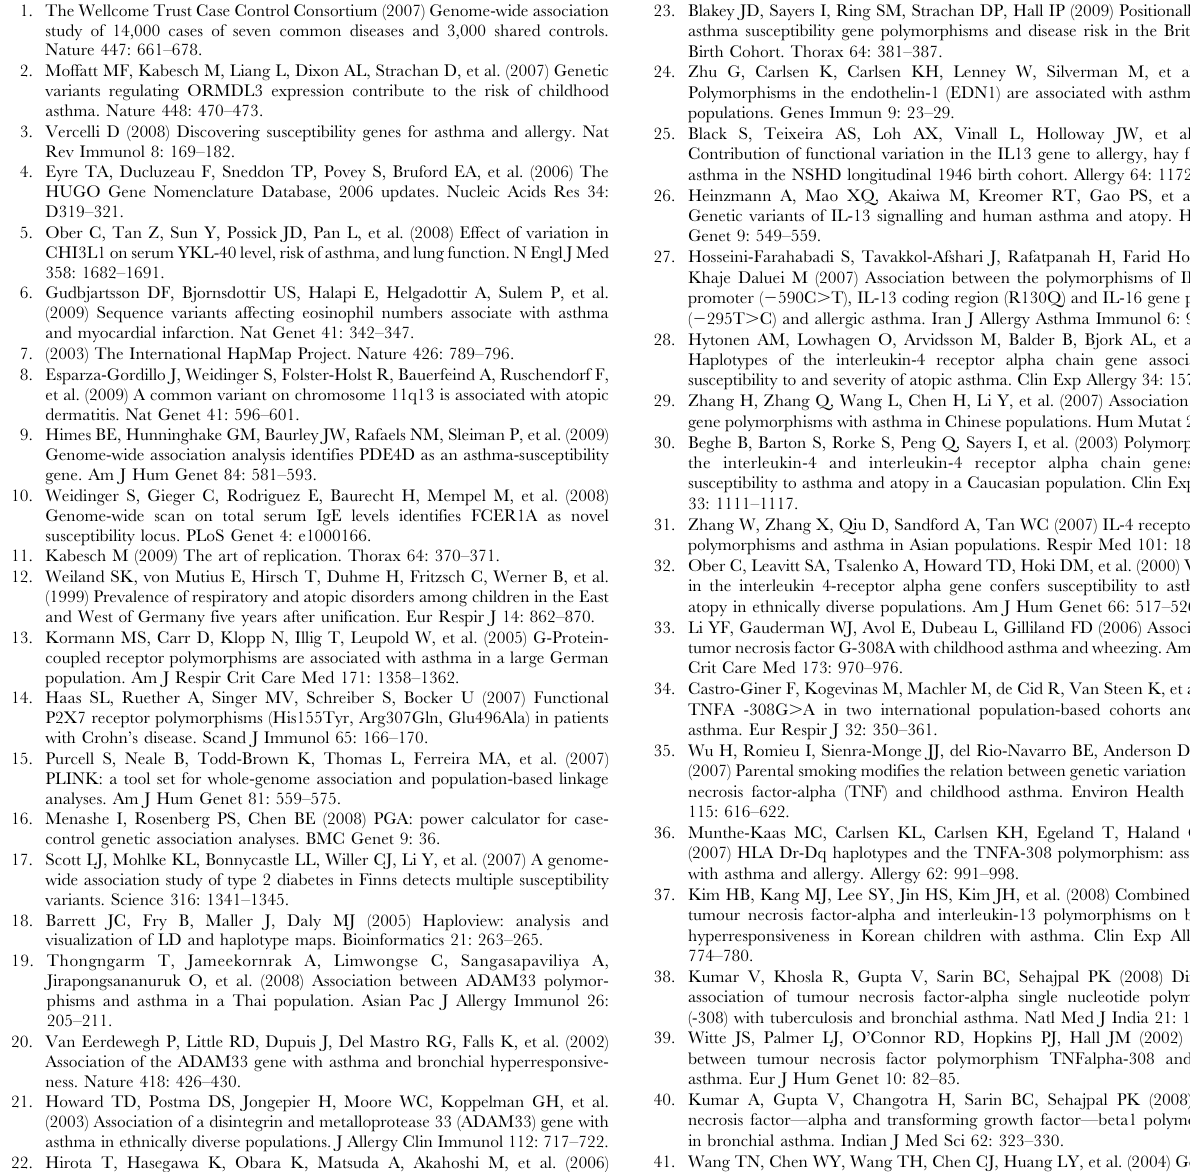
last exon are given and in brackets ( ) genotyped or covered